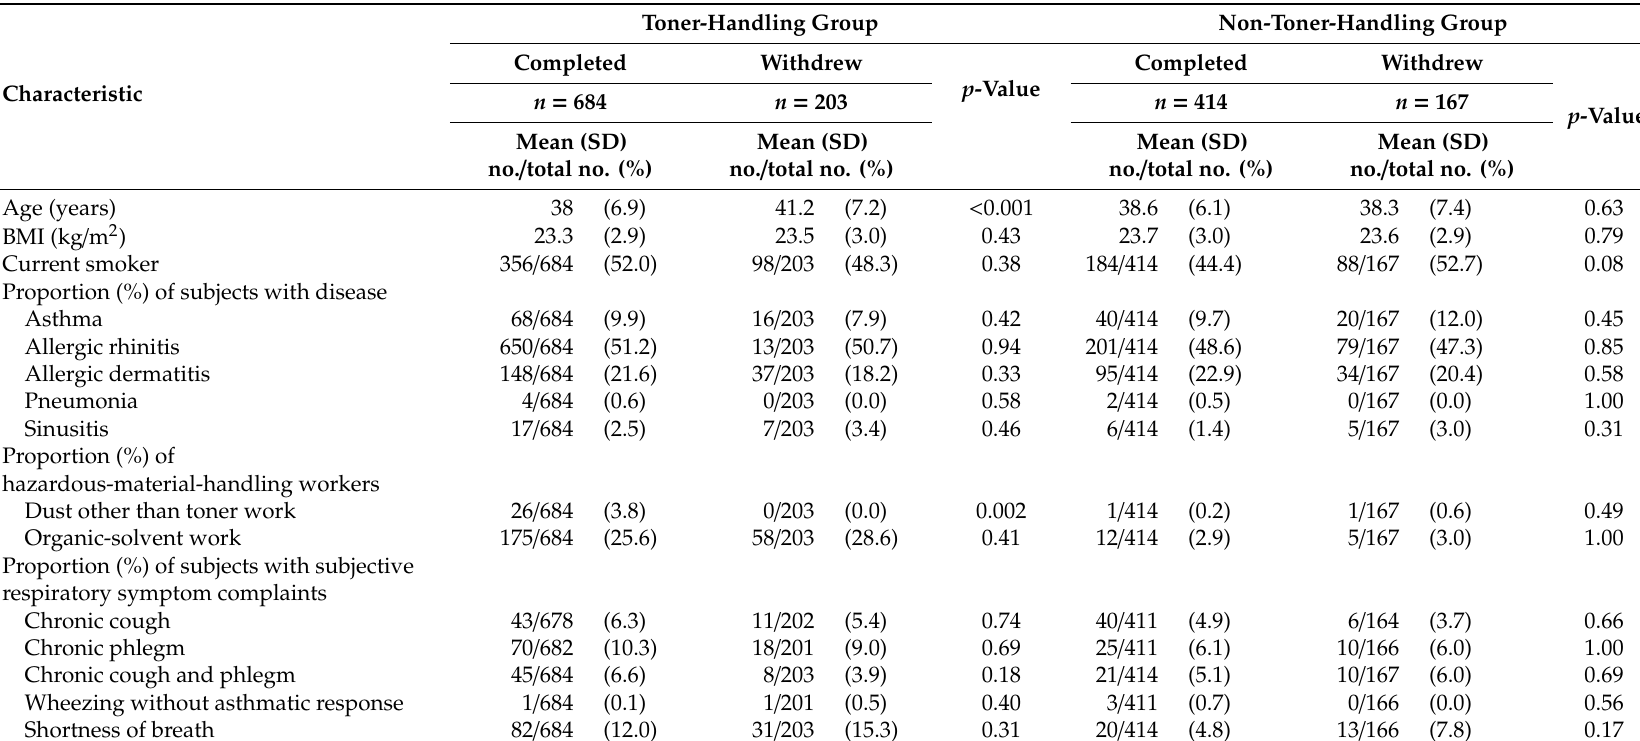
Table 2. Comparison of participants’ baseline characteristics and respiratory symptoms between those who withdrew and those who completed follow-up.